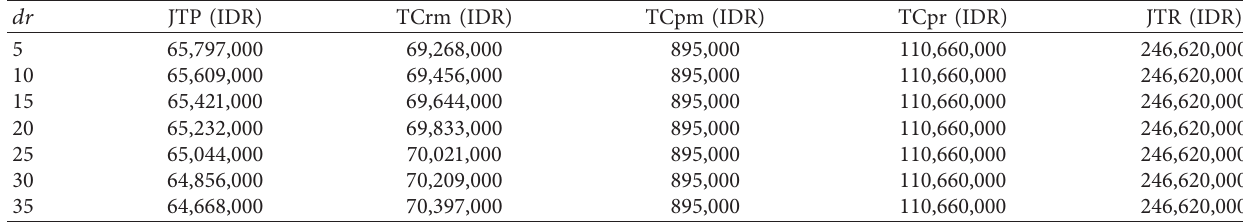
Table 9: Sensitivity analysis of the influence of dr on cost, revenue, and profit.